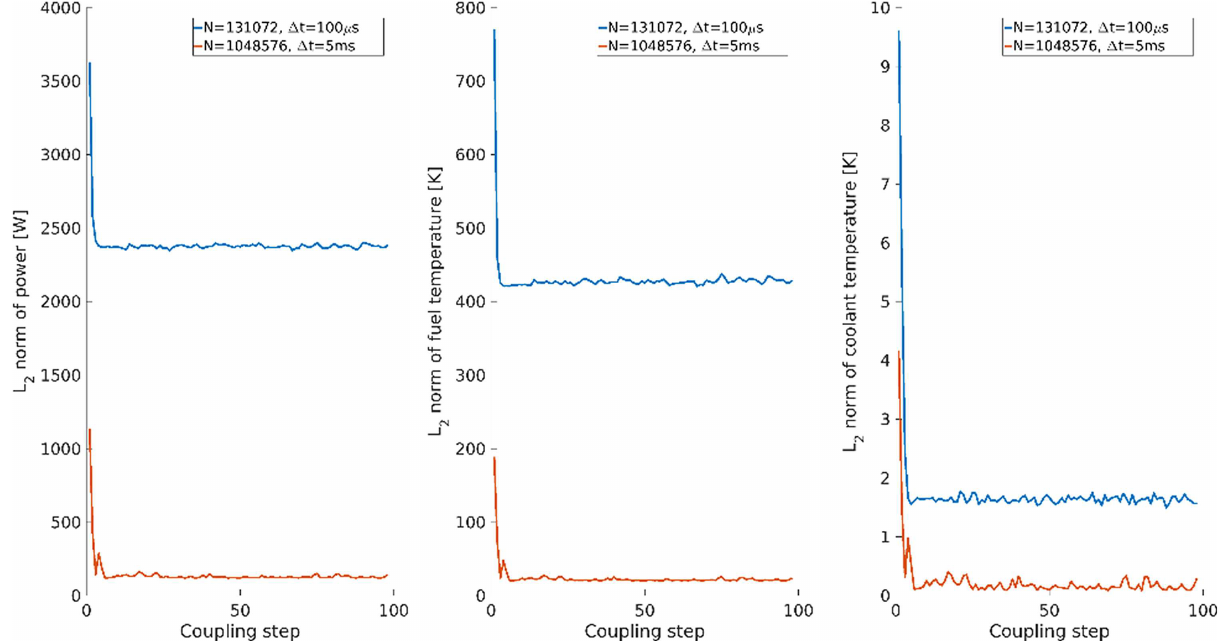
Fig. 6. L 2 norm evolution of the GD source convergence for Run #1 (red) and Run #2 (blue).